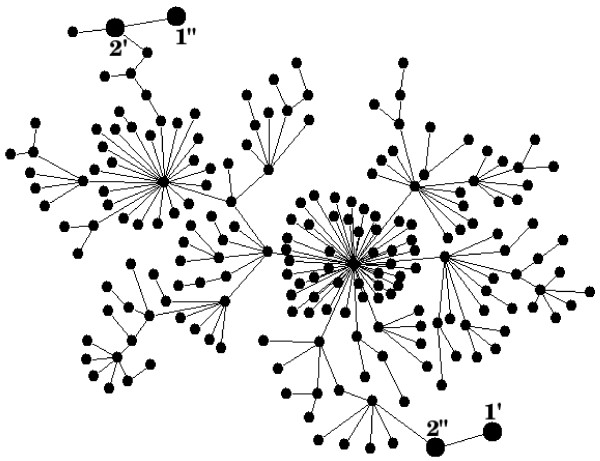
The model network of conformational substates. The model network of stochastic transitions between conformational substates (nodes) corresponding to the shaded box M in Figure 3. Its structure displays both the scale-free topology, as well as the fractality [31]. The distinguished nodes (enlarged dots) symbolizes the gates which have been marked here in accordance with a system of labels used in Figure 3.